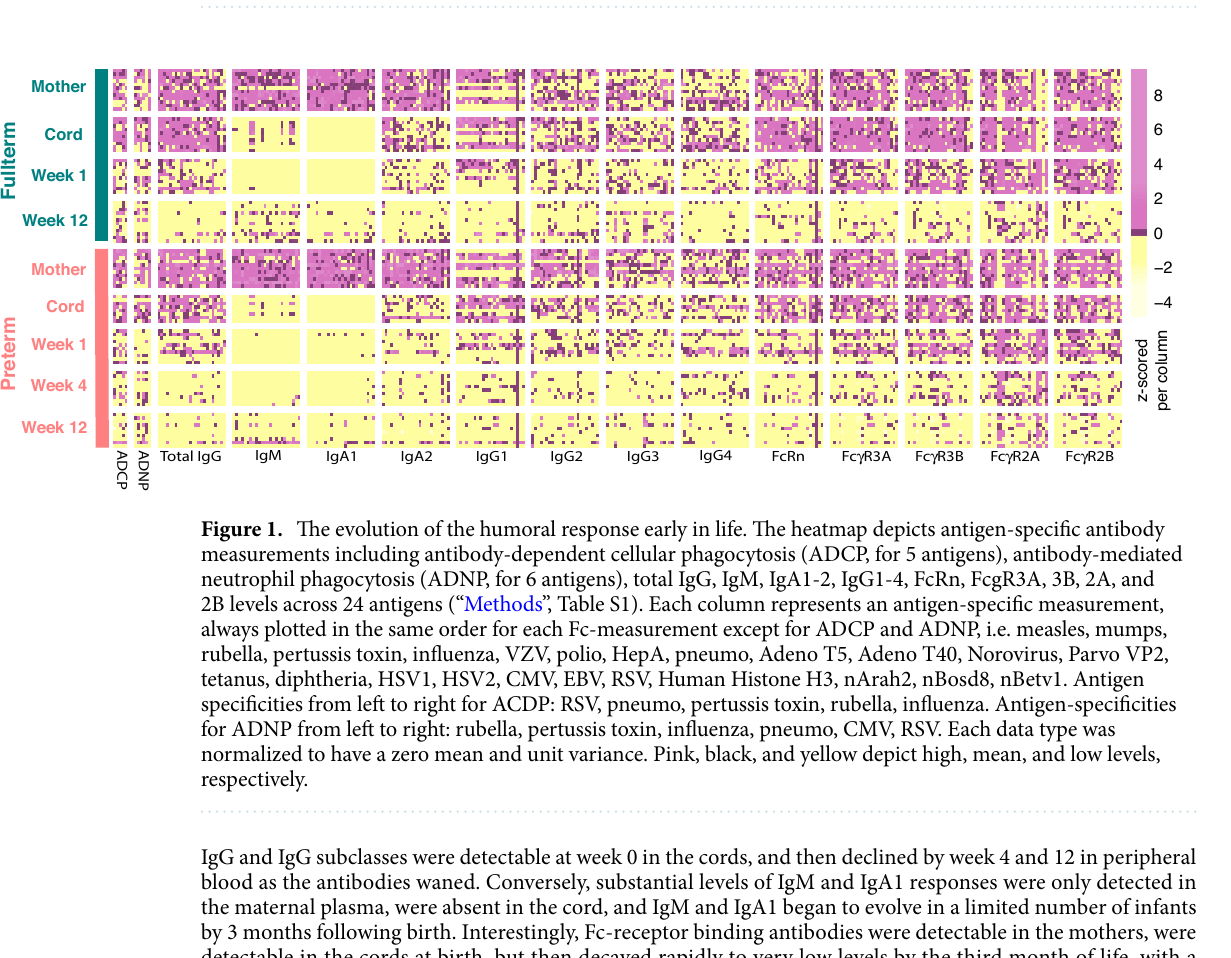
Table 2. Sample characteristics. a Rota virus. b Pneumococci. c Diphteria, tetanus, pertussis, hep B, polio, Hib. d